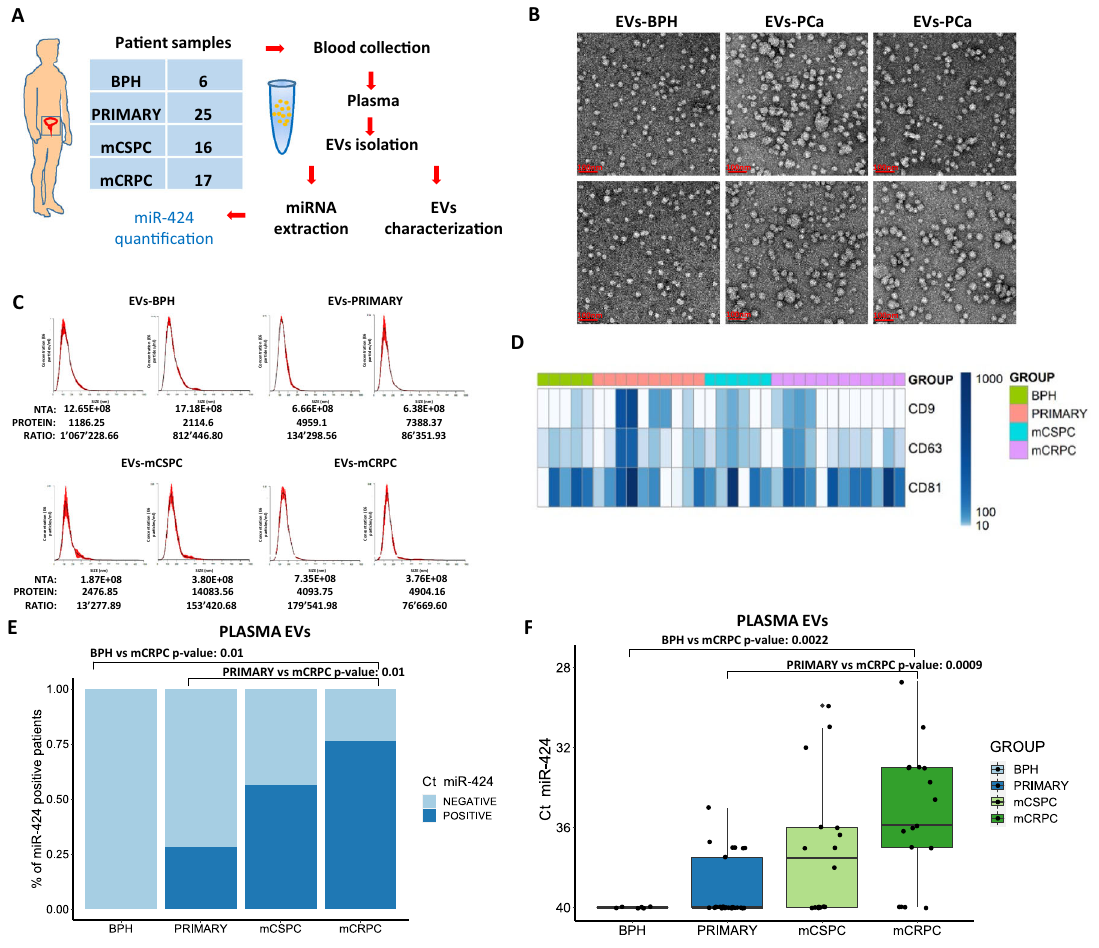
Fig. 1 Metastatic prostate cancers release miR-424 containing extracellular vesicles in patient plasma. A Scheme of the experimental plan for isolation and characterization of EVs from patient plasma. B and C Representative images of transmission electron microscopy (TEM) and nanoparticle tracking analysis (NTA) of patient-derived EVs. EVs protein concentrations and ratios between NTA counts vs. protein are reported. D Expression of EVs surface markers in patient-derived EVs determined by MACSPlex analysis. E Percentage of miR-424-positive EVs isolated from plasma of patients with BPH and prostate cancer. F miR-424 expression levels (Ct values) in EVs from patient plasma. Comparisons with signi fi cant p -value (<0.05) are indicated and only signi fi cant p -values are reported. n = 6 BPH, n = 25 PRIMARY, n = 16 mCSPC, n = 17 mCRPC. In NTA panels the unit of measurements were